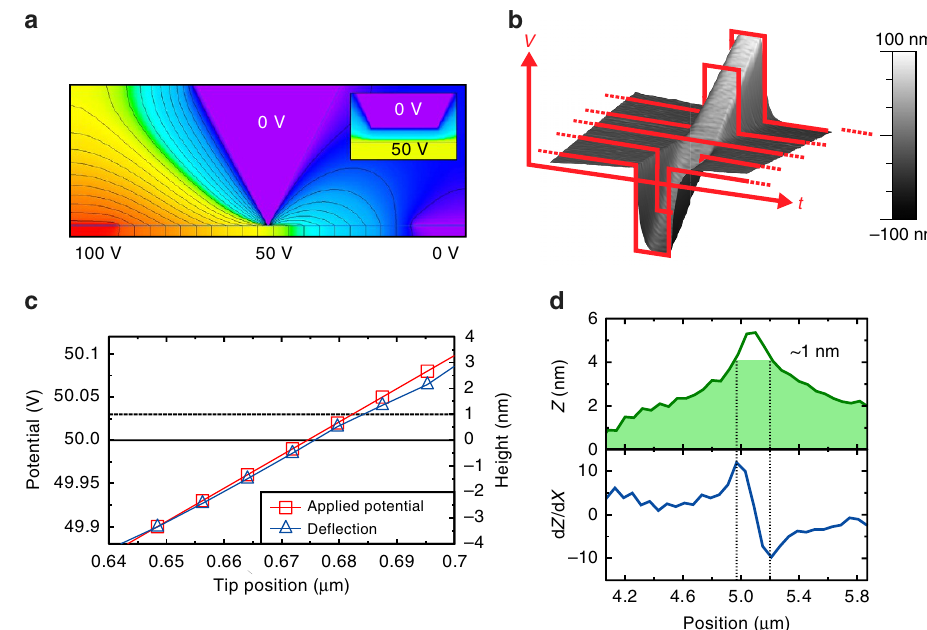
Figure 4 | Calibration to obtain quantitative estimate for domain wall Hall voltage. ( a ) Quickfield modelling of the tip and YbMnO 3 surface, with B 100V potential difference between source and drain electrodes, verified that measurements of the Hall voltage were set against a DC potential background of around 50V. ( b ) To calibrate the tip deflection associated with the Hall voltage measurements at domain walls, the topography of a gold-coated SrTiO 3 single crystal was monitored as negative and positive voltage pulses (schematically represented as red lines of V ( t )) were supplied to the crystal surface (schematically superimposed onto a background DC potential of 50V). A smooth correlation between the applied voltage pulse and the topographic deflection was found. ( c ) A section of the measured topography associated with the ramp in b and the voltages responsible (voltage pulses plus 50V DC background). ( d ) The topography signal, Z , across a conducting domain wall in which a Hall voltage has developed and the associated derivative, d Z /d X , show that the above background topographic peak is B 1nm in height. This corresponds to a voltage of around 30mV from the calibration graph in c (dashed